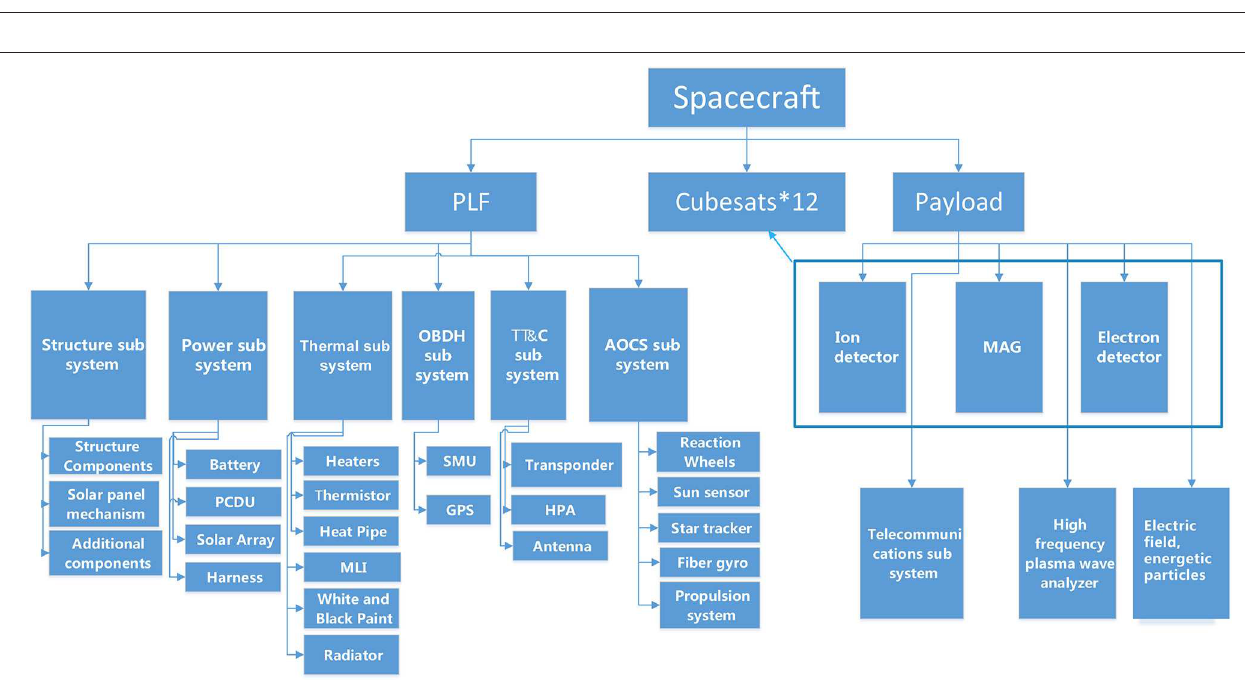
FIGURE 9 | The spacecraft product tree of the main spacecraft and CubeSats.